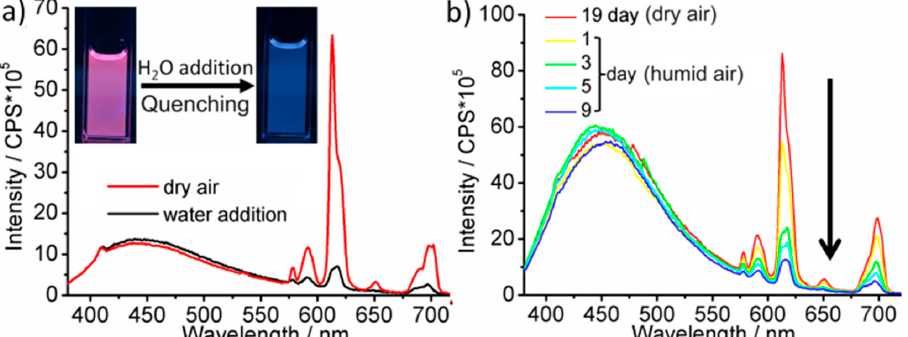
Figure 4. H 2 O-driven quenching of conventionally-heated Eu-modified C-dots: ( a ) photographs and PL spectra with time-depending emission upon addition of water (UV-LED excitation); and ( b ) PL spectra during humid air treatment ( λ exc = 366 nm; normalized on C-dot emission at 440 nm).